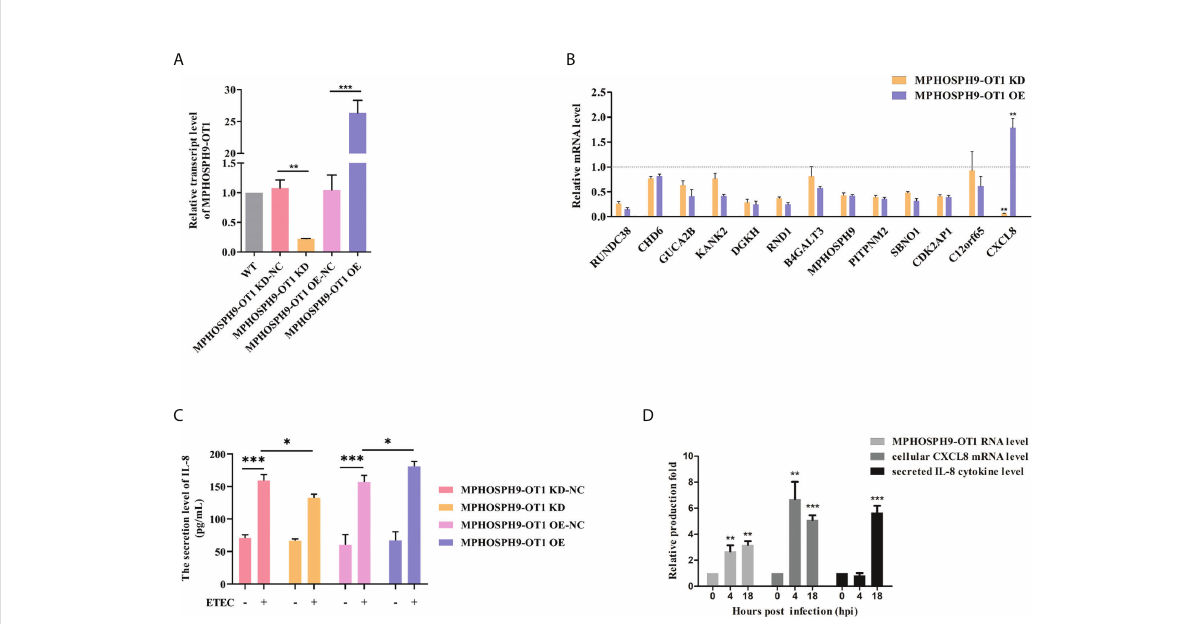
FIGURE 5 MPHOSPH9-OT1 positively regulates cellular CXCL8 expression and IL-8 secretion after ETEC infection. (A) Establishment of MPHOSPH9-OT1 knockdown and overexpression IPEC-J2 cell lines. WT represents wild-type IPEC-J2 cells without any treatments. KD-NC indicates negative control cells transfected with lentiviral vector carrying scrambled sequences for shRNA used in KD cells. OE-NC indicates negative control cells transfected with empty LV5 lentiviral vectors. (B) Expression veri fi cation of MPHOSPH9-OT1 predicted target genes using qRT-PCR. The qRT- PCR analysis was performed using the 2- DD Ct method normalized to GAPDH. The relative transcript levels were calculated using gene expression values of KD/OE cells divided by that of the corresponding negative control cells. The relative transcript values below the grey dotted line mean decreased mRNA levels in given cells compared to corresponding NC, and increased mRNA levels were above the dotted line. (C) Assessment of secreted IL-8 levels in the culture medium using ELISA. (D) The expression pro fi les of cellular MPHOSPH9-OT1 transcript, cellular CXCL8 transcript, and secreted IL-8 cytokine levels during ETEC infection. *P<0.05, **P < 0.01, ***P<0.001 compared to 0